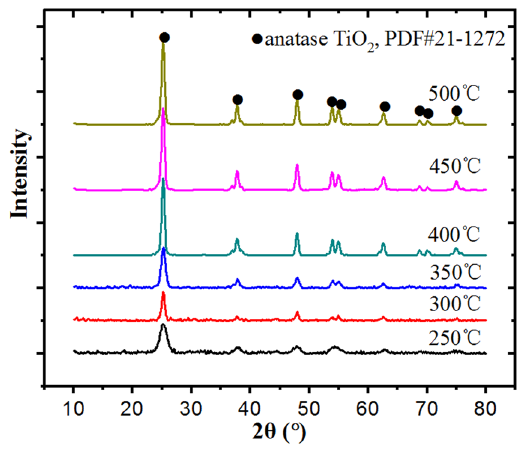
Figure 1: XRD results of products synthesized at di ff erent temperatures and 30